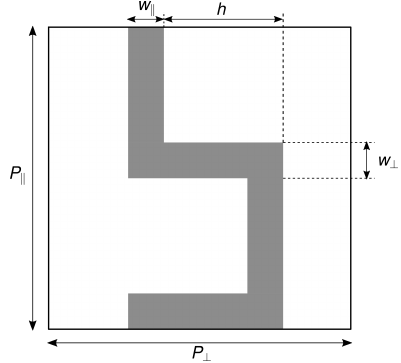
Figure 4. Geometry of meander line unit